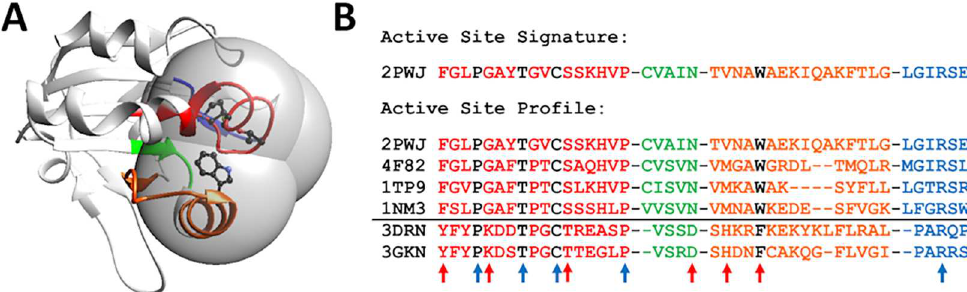
Fig 1. Active Site Profiling identifies molecular featuresaround a protein’s functional site. (A) In an enzyme structure, key functionalresidues (black side chains) are identified from sequenceand structural analysis. All residueswithin 10 Å of any key residue (gray spheres) are identified [35,36].The visualizationwas created using UCSF Chimerapackage,version1.10.2 (B) Residueswithin the 10 Å spheresare extracted and concatenated to form an active site signature(top). Signaturesfrom a protein family are alignedto create an active site profile (ASP) (bottom). Within the profile, molecularfeatures that are common across the superfamily (blue arrows), as well as features that seem to divide the profile into two distinct groups(red arrows), can be identified. The black line separates the two functionalfamilies with Prx5 proteinson top of the line and PrxQ proteinsbelow the